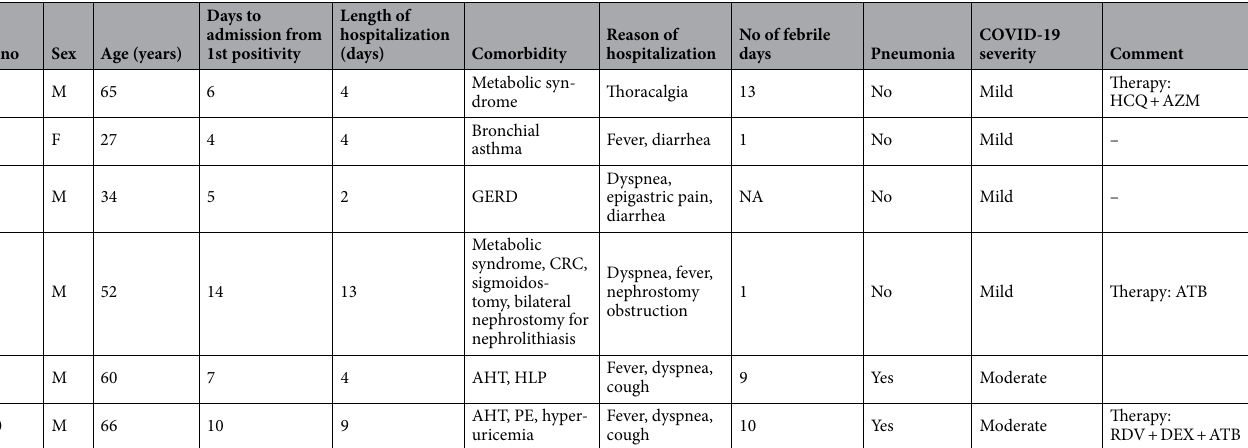
Table 3. Baseline characteristics of 6 outpatients with SARS-CoV-2 positivity during secondary hospitalization. SARS‑CoV‑2 severe acute respiratory syndrome coronavirus 2, ID no identification number, COVID‑19 coronavirus disease-19, GERD gastroesophageal reflux disease, AHT arterial hypertension, NA not applicable, DEX dexamethasone, ATB antibiotics, RDV remdesivir, HCQ hydroxychloroquine, AZM